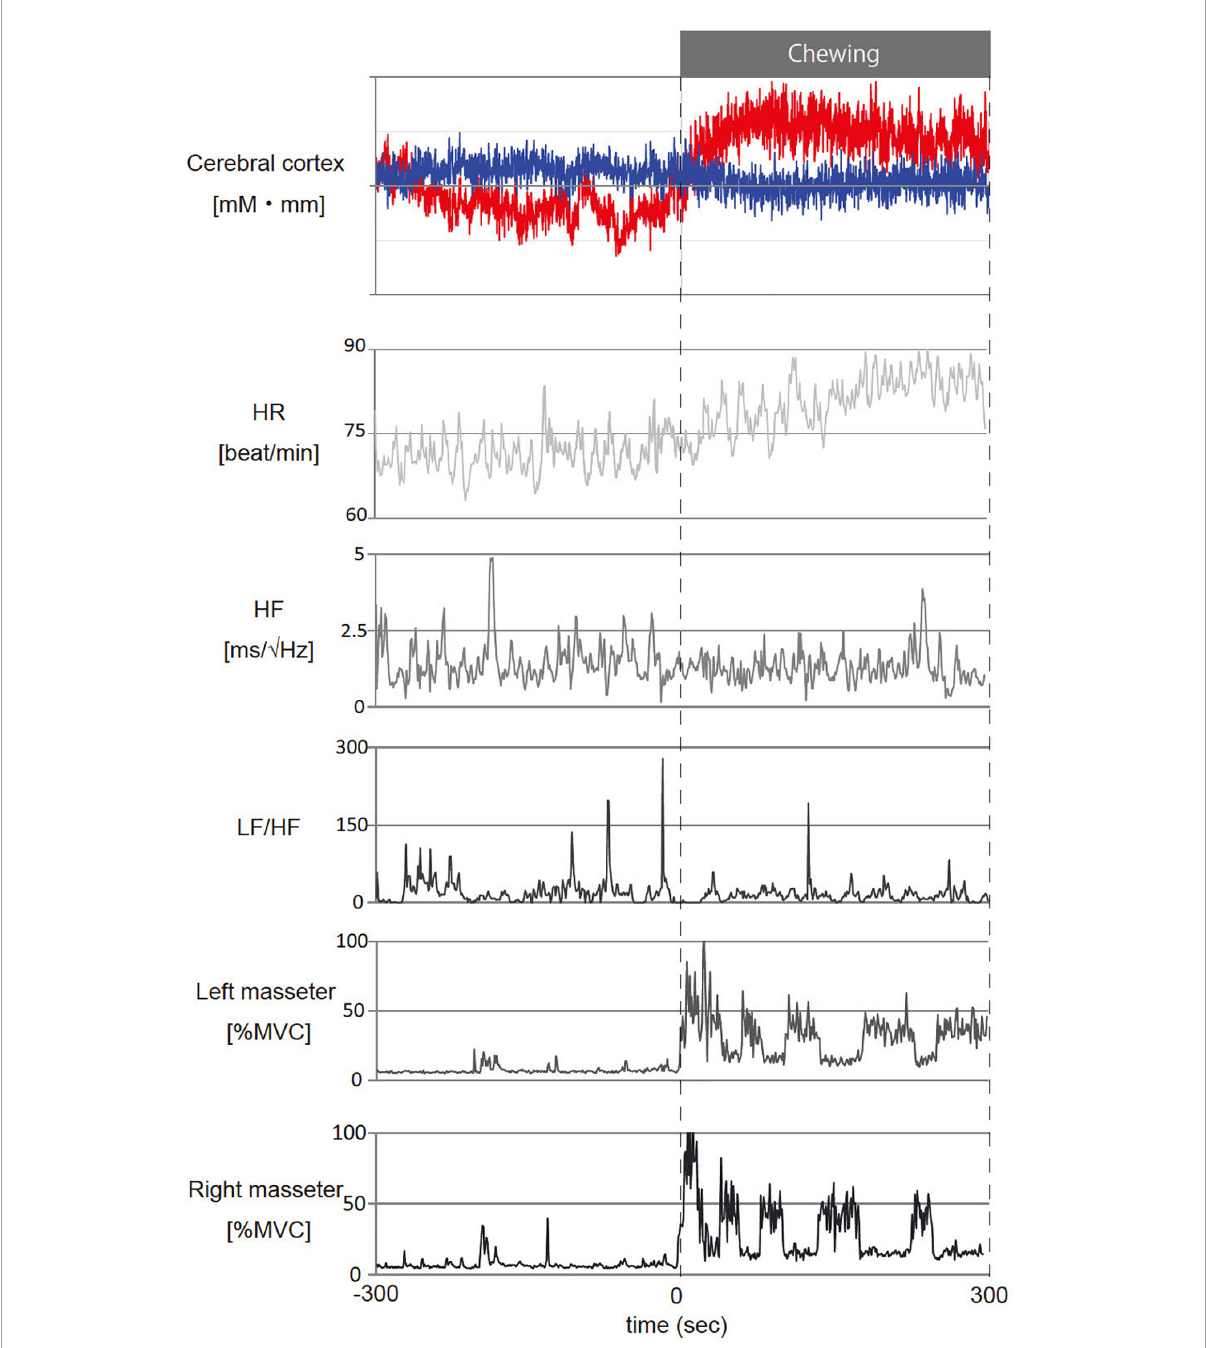
FIGURE4 Representative temporal changes in oxy- and deoxy- hemoglobin (Hb) in channel 24, heart rate (HR), cardiac vagus nerve activity (RR-HF), cardiac sympathetic nerve activity (RR-LF/HF) and left/right masseter mass activity (l-%MVC, r-%MVC) during gum chewing. The red line in the cerebral cortex shows oxy-Hb and the blue line shows deoxy-Hb. –300 to 0 s: Before chewing and 0 to 300 s: During chewing. The calculations represent the values per second for the data.